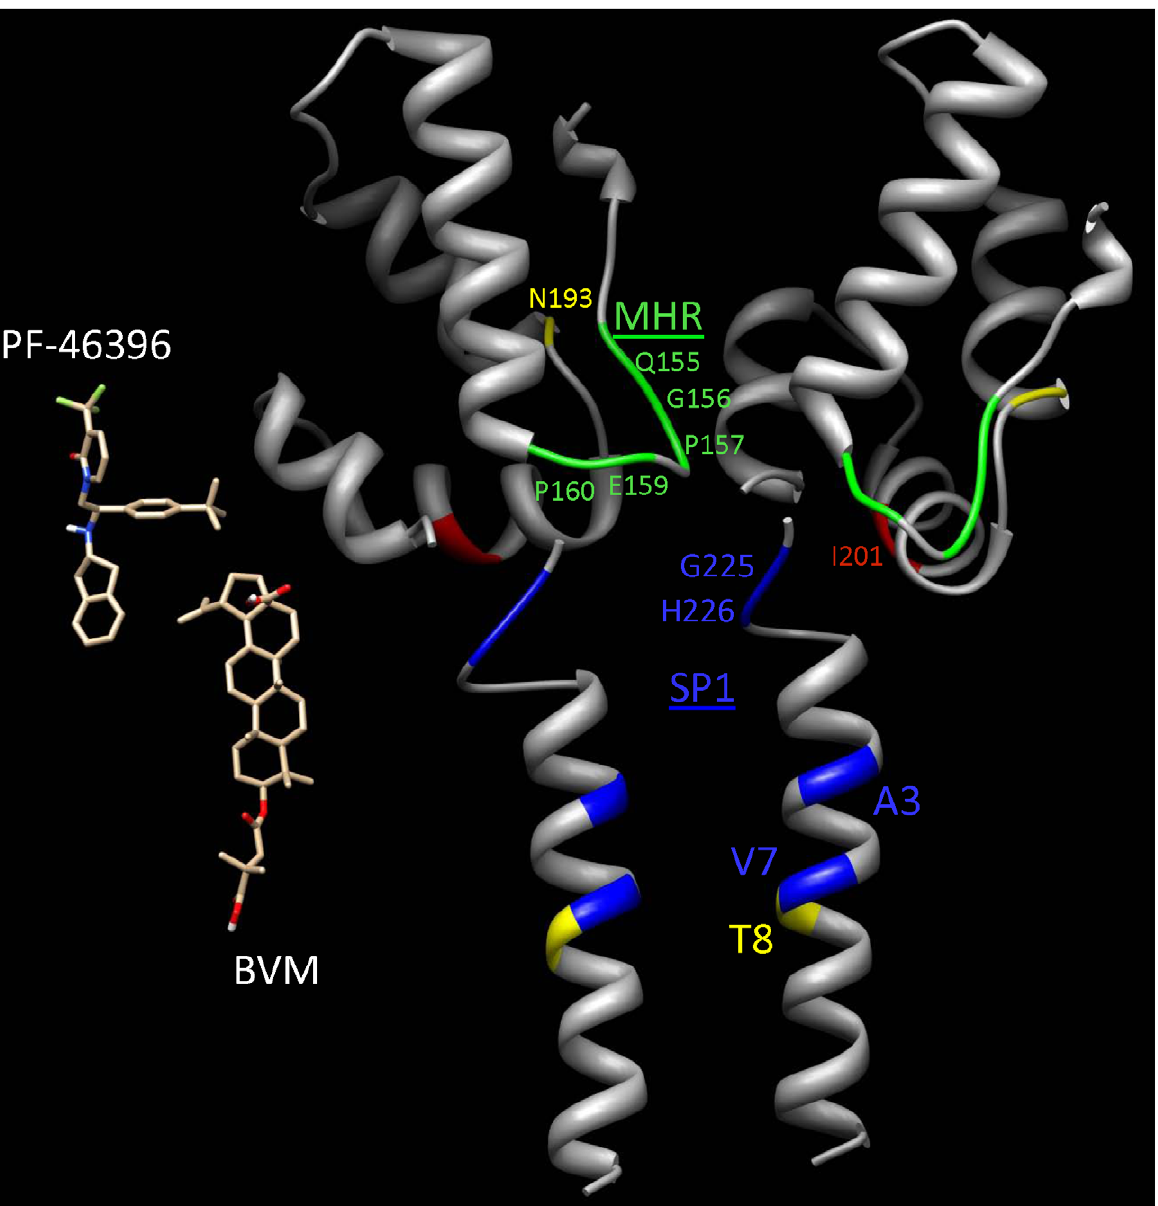
Figure 13. Schematic molecular model of PF-46396 and BVM binding sites. The ribbon diagrams illustrate two adjacent CA-CTD/SP1 monomers in the hexagonal complex of the immature capsid. The atomic coordinates of the CA-CTD and SP1 domains were obtained from PDB 3H4E [66] and PDB 1U57 [27], respectively. Residues 220–223 that link the CA-CTD and SP1 domains of each monomer were not modeled due to a lack of experimental data. The relative orientations of the adjacent CA-CTD domains were taken from the models of Bharat et al. [61]. The sites of resistance mutations are labeled and color-coded for location: Green, blue and red for the MHR, CA-CTD/SP1 boundary, and individual I201 residue, respectively. Yellow indicates the sites of secondary substitutions that rescue the G156E and P157S mutants. Also shown are stick figures of the PF-46396 and BVM compounds at the heights of their respective binding sites predicted from the locations of the resistance mutations (color-code: C – brown, N - blue, O - red, H – white, and Fl – green). The rotational orientation of PF-46396 is arbitrary, but that of BVM is taken from the photoafinity data of Nguyen et al. [45]. The proximity of the MHR of the left monomer to the CA-CTD/SP1 region of the right one suggests that the binding sites of the two compounds straddle adjacent monomers. This would explain the observed necessity of Gag assembly into the immature capsid structure for BVM cleavage inhibition (see text).